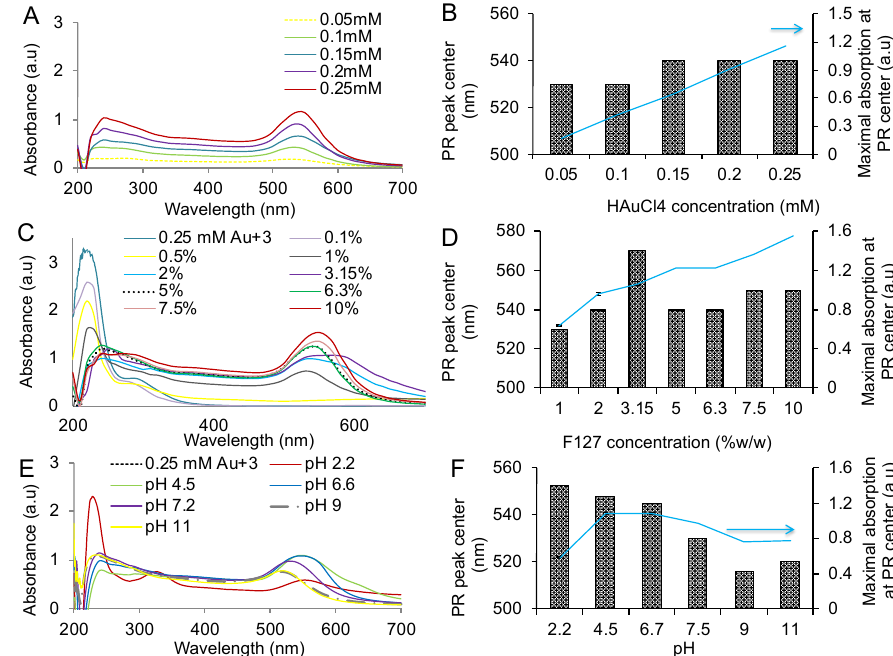
Figure 4. ( A , C , E ) Absorbance spectra, and ( B , D , F ) the position of the PR peak maxima (columns) and the maximal PR absorbance intensity ( (cid:78) ) in the mixtures containing HAuCl 4 and F127 after 2 h incubation at 45 ◦ C. ( A , B ) HAuCl 4 concentration is constant (0.25 mM) and F127 concentration varied from 0.1 to 10 % w / w . The pH of the F127 solution before HAuCl 4 addition was pH 6.5. In all cases reaction is complete based on the absence of a peak at 220 nm or shift of the pick to 240 nm for 0.25 mM. ( C , D ) F127 concentration is constant (6.3% w / w ), HAuCl 4 concentration is varied from 0.05 to 0.25 mM. The pH of the F127 solution before HAuCl 4 addition was pH 6.5. ( E , F ) 0.25 mM HAuCl 4 and 6.3% w / w F127 mixture was adjusted to various pH.